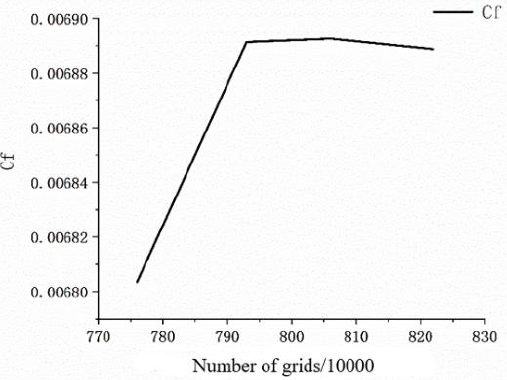
Figure 12. Frictional drag coefficient of triangular groove plate under different mesh numbers.